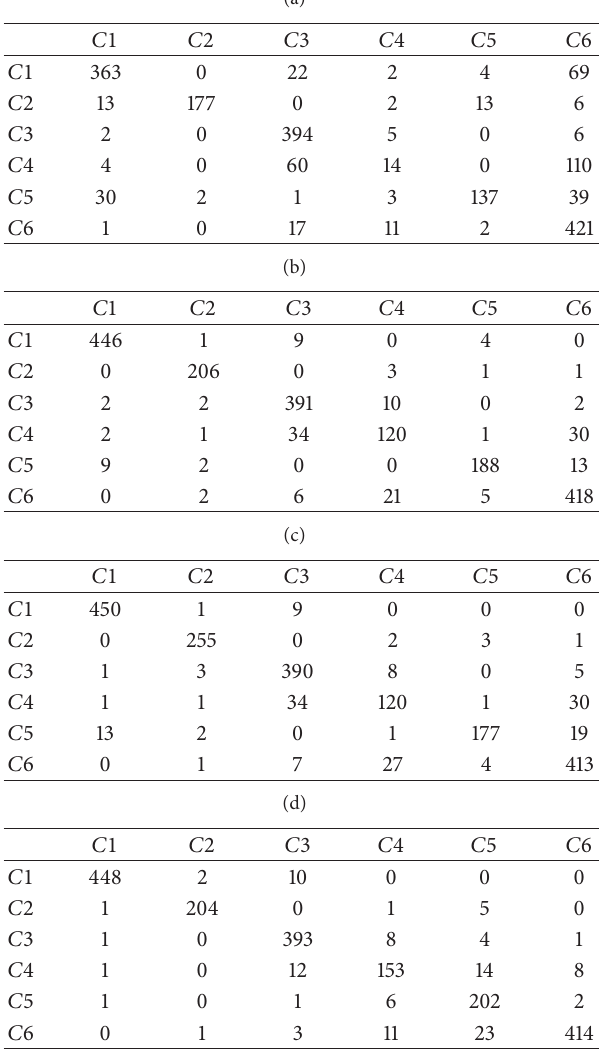
Table 7: Confusion matrices of (a) Adaboost, (b) Bagging, (c) RSM, and (d) proposed approach using DiaretDB dataset.